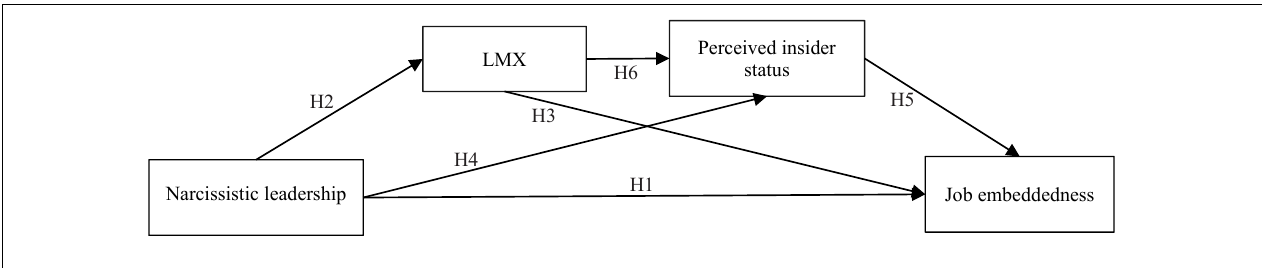
FIGURE 1 | Theoretical